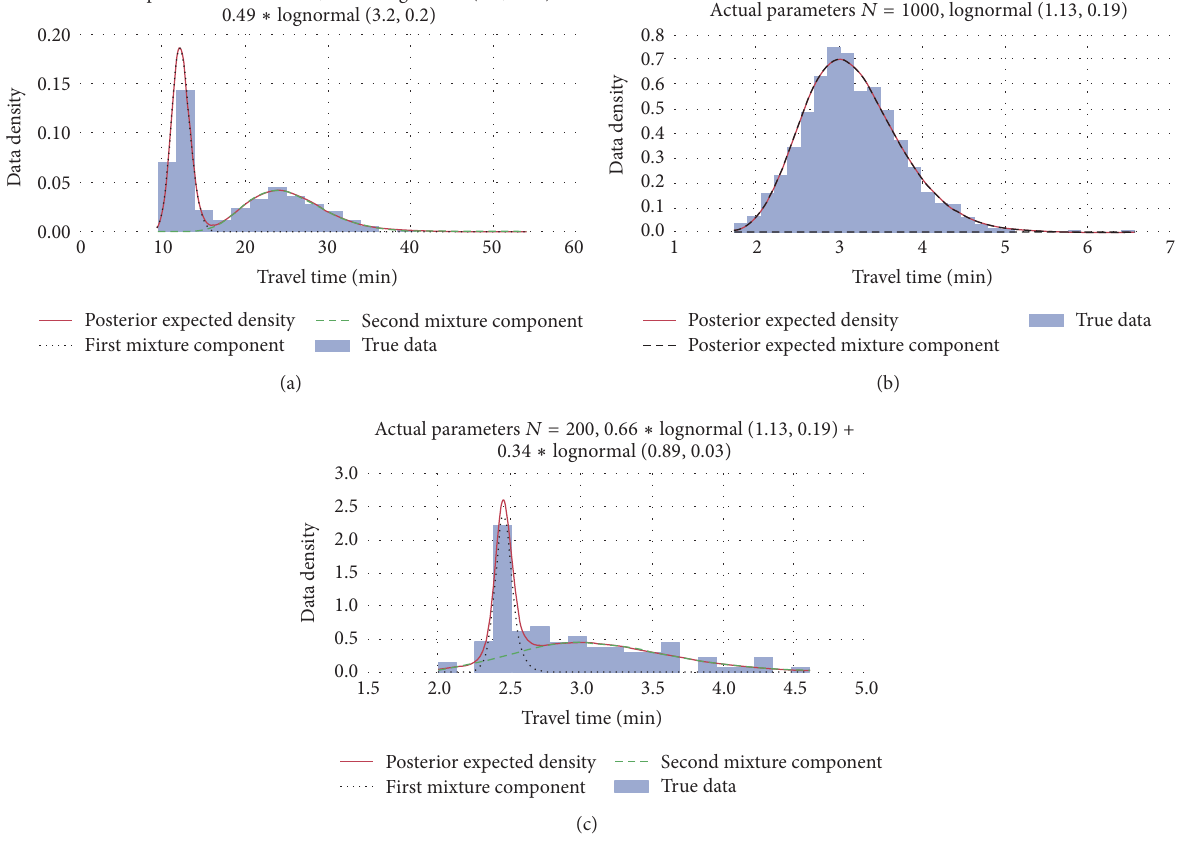
Figure 6: Estimated travel time distributions of the simulated data.